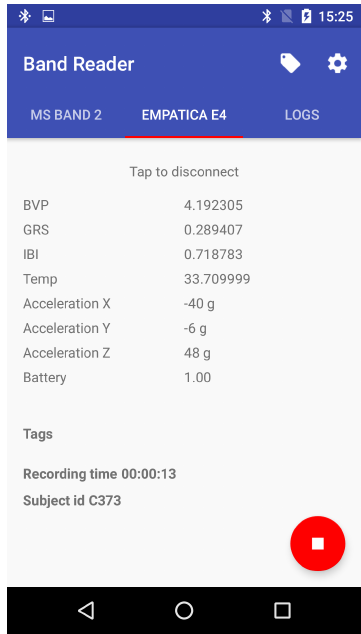
Figure 13. BandReader application online: physiological signals from Empatica E4 are being collected [35].